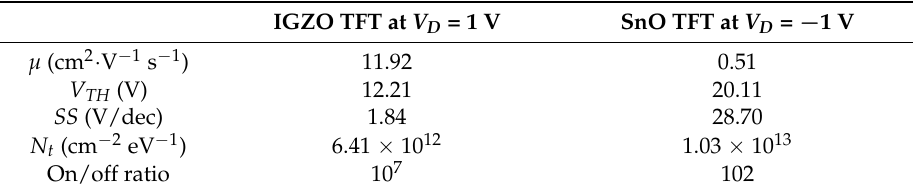
Table 1. Electrical characteristics of the IGZO and SnO